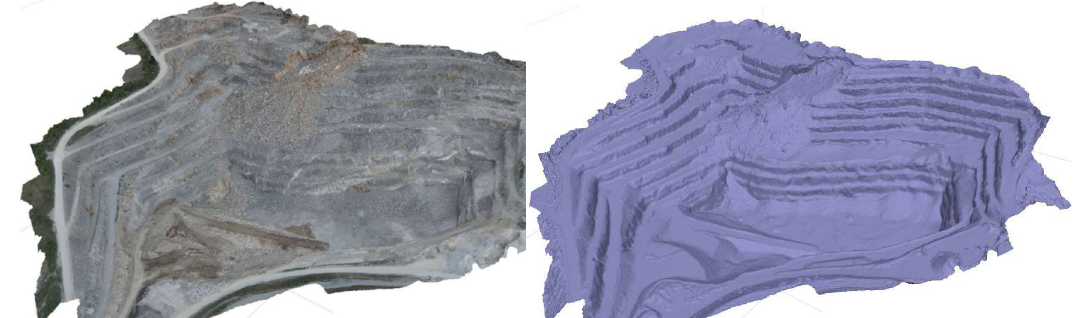
Figure 4. Laže 1 quarry, 3D view toward the north. The terrain model was created using unmanned aircraft photography. Left: the model is covered with photos. Right: a digital relief model with a 10 × 10 cm grid.